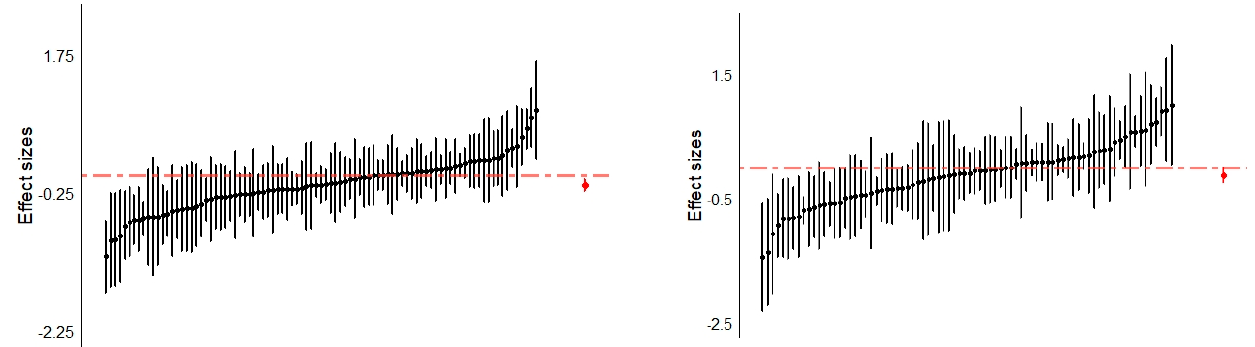
Figure 3. Caterpillar Plots of Individual Effect Sizes in TLMA 1 ( Left ) and TLMA 2 ( Right ). Note. The black dots represent all biomarker effect sizes (Level 2) and their corresponding 95% confidence intervals. The red dot represents the pooled effect estimate, the red line the absence of an effect ( g = 0).